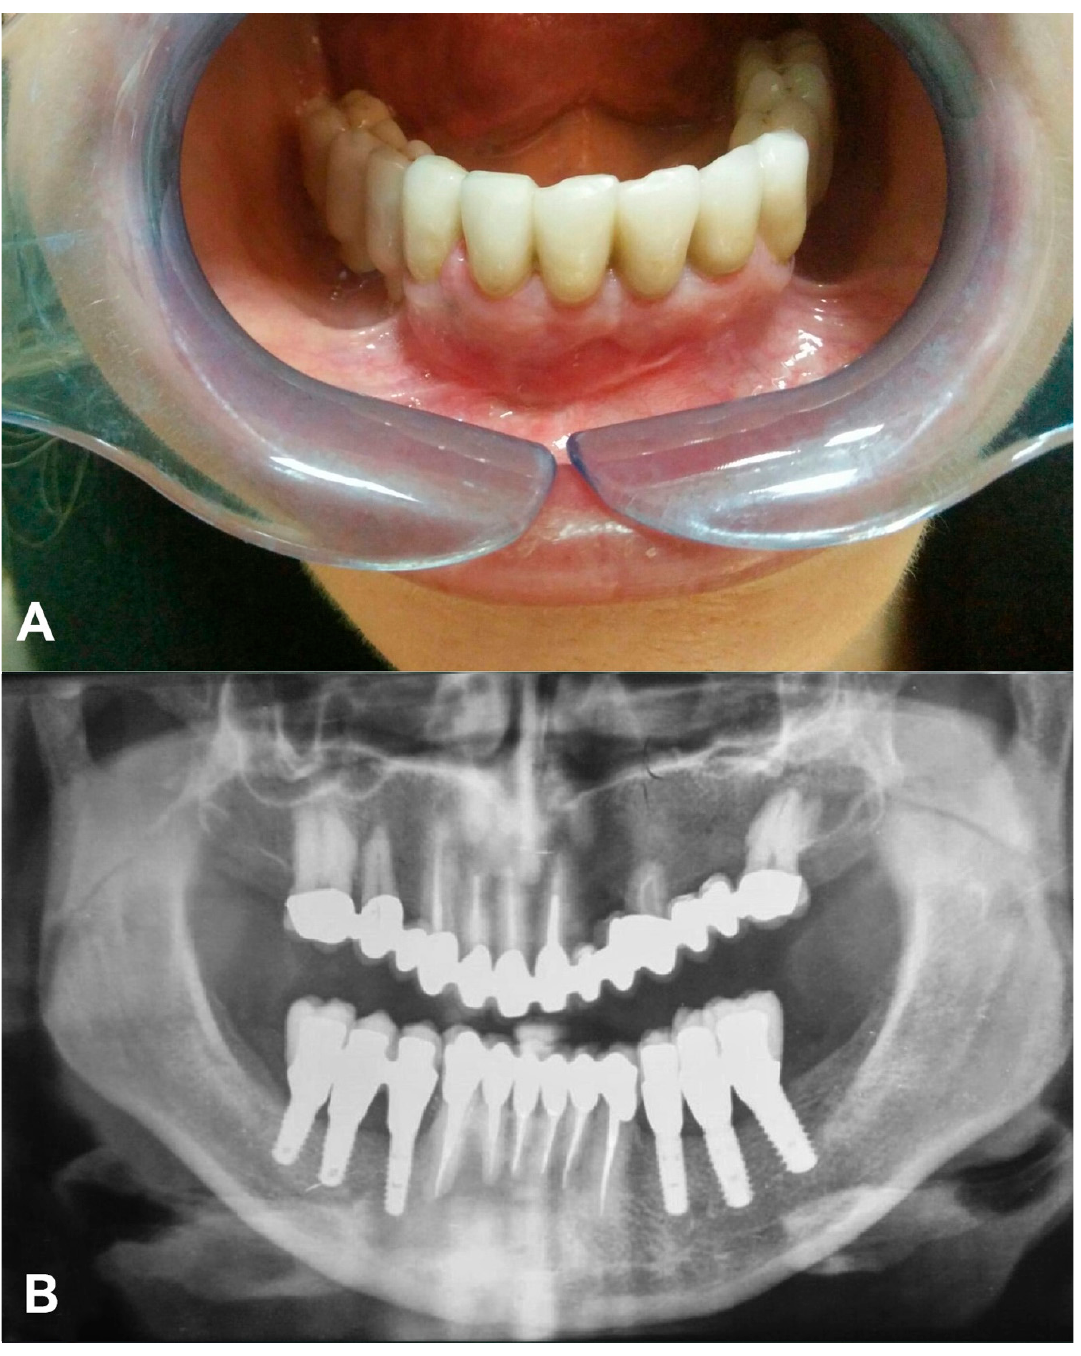
Figure 4. Five month follow-up. ( A ) Intraoral view; ( B ) Orthopantomography.